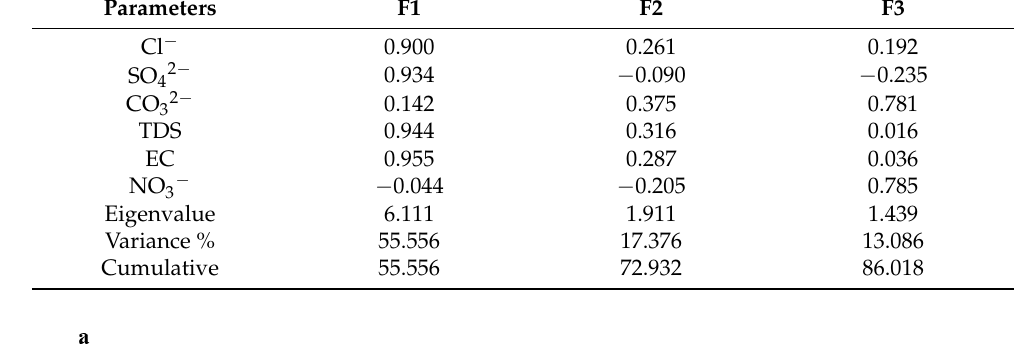
Table 4. Correlation between the parameters and factors.